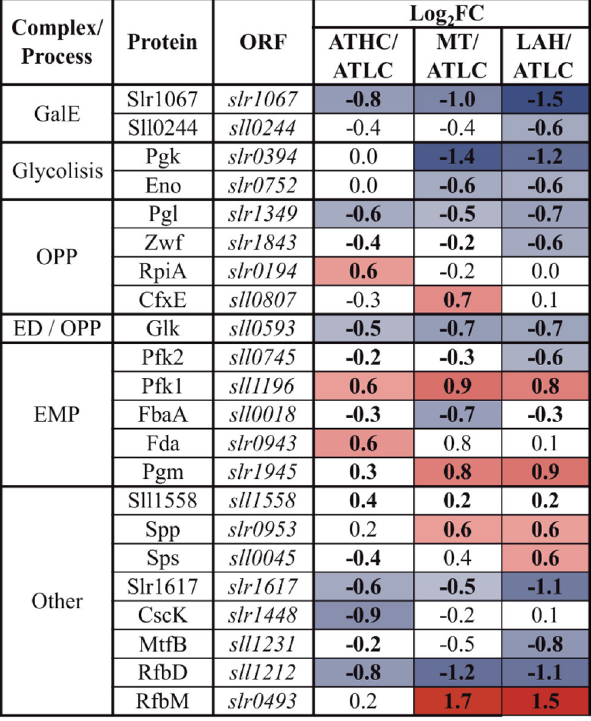
The gradient from blue to red was applied to highlight the proteins above the practical fold change threshold ( − 0.5 8 > log 2 FC > 0.58), with lowest to highest abundance, respectively, in relation to the ATLC growth condition. Statistically significant results (p < 0.05) are highlighted with bold font.